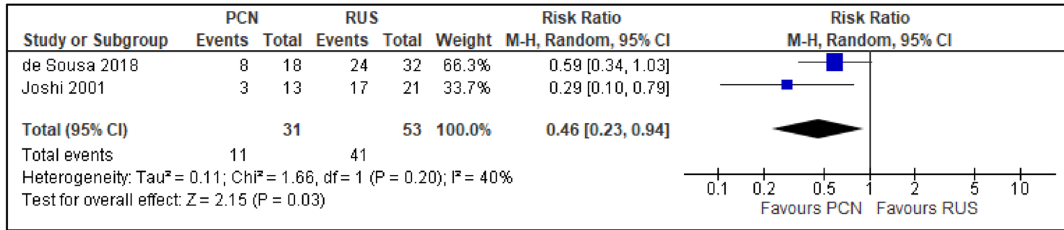
Figure 14. Comparison between PCN and RUS for outcome